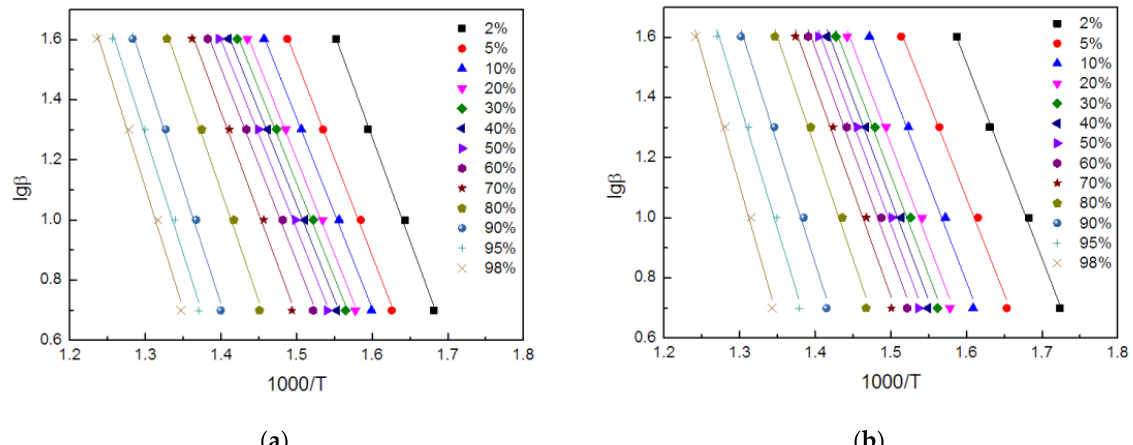
Figure 8. Conversion of TE ( a ) and FRTE ( b ) as a function of temperature.